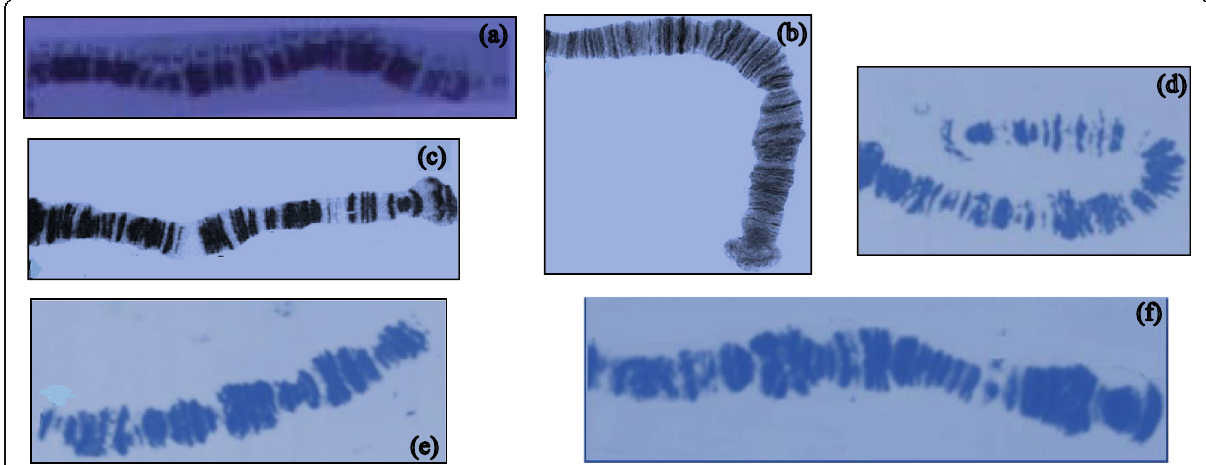
Fig. 4 Arm C of the polytene chromosomes of six species of Chironomus. a C. javanus. b C. dorsalis. c C. riparius. d C. matures. e C. maddeni. f C. duplex